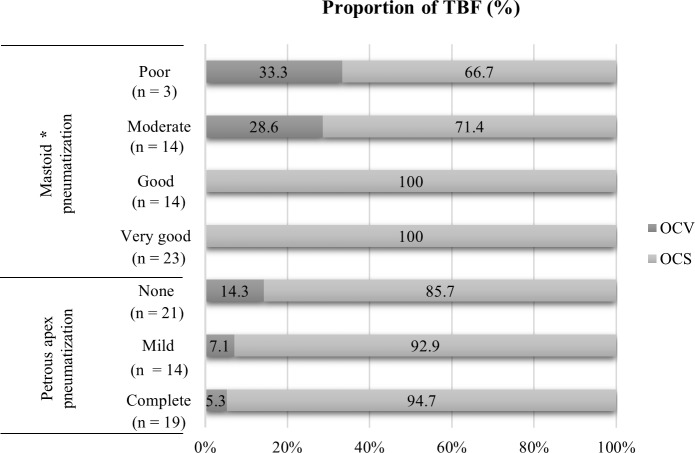
Proportion of temporal bone fractures with otic-capsule violation.Temporal bones with the reduced pneumatization were more likely to have OCV fractures than those with good pneumatization. TBF, temporal bone fracture; OCV, otic-capsule violating; OCS, otic-capsule sparing; asterisk, statistically significant (P< 0.05).